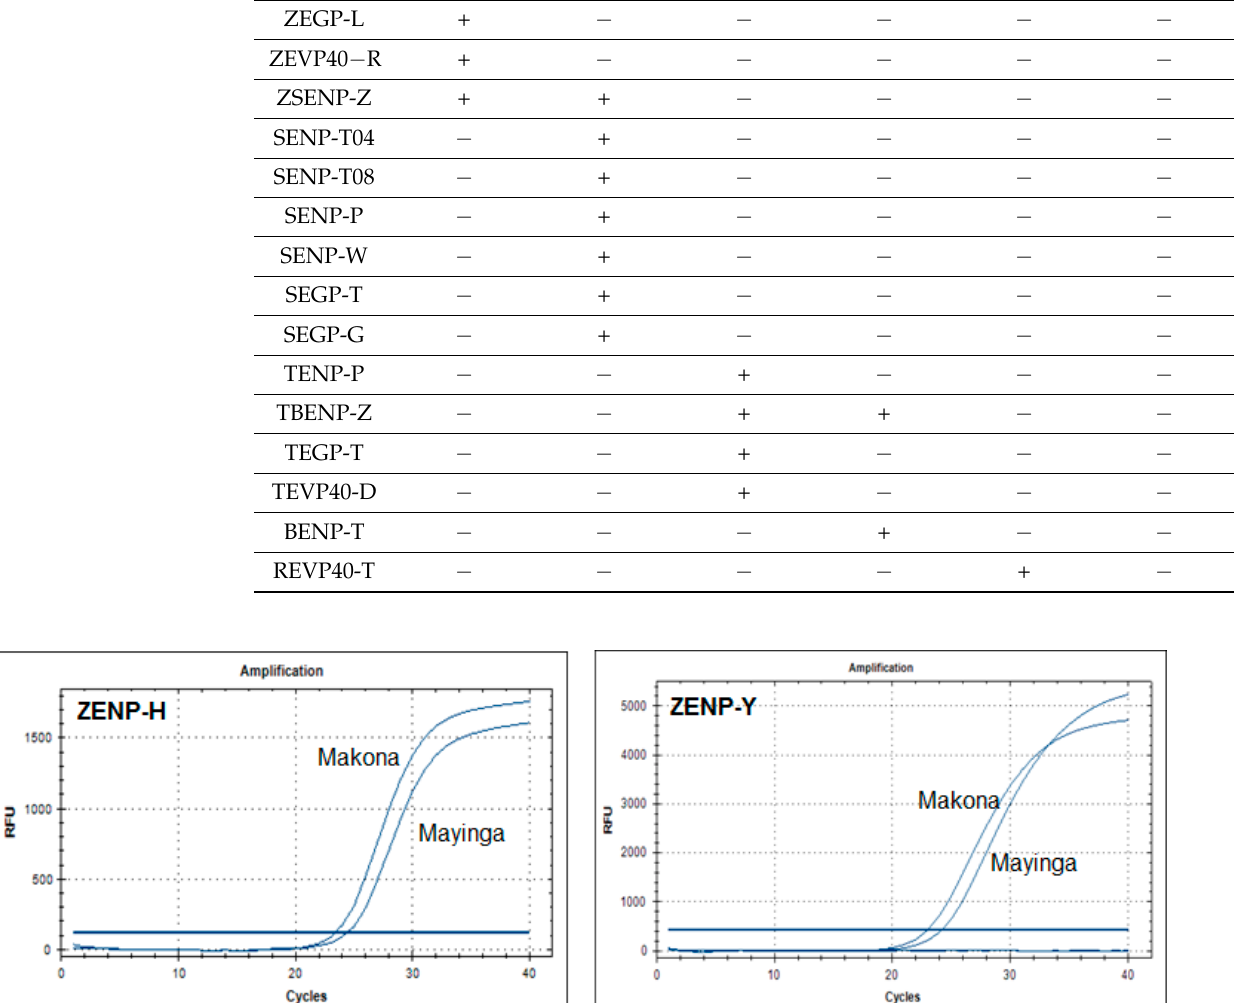
Figure 2. Specificity of ZENP-H, ZENP-Y, ZSENP-Z and ZEVO40-R assays for the EBOV Mayinga variant and the Makona variant. The specificity of ebolavirus species-specific real-time RT-PCR assays was examined using viral RNA extracted from the supernatant of cells infected with the EBOV-Mayinga variant and the Makona variant. Outside these assays, there was no difference in assay specificity between the two variants. 4. Discussion The two deadliest ebolaviruses epidemics have occurred in the past 5 years, and one of these epidemics is still ongoing. In the case of an epidemic emergency, the first line of response should be an accurate and quick virus detection. Nucleic acid detection is the most common procedure for diagnosing EVD because of its unsurpassed specificity and sensitivity, as well as its ability to detect acute infection. Additionally, the virus does not need to be viable at the time of testing [38]. In recent years, real-time RT-PCR for the diagnostics of emerging virus infection has proven to be an invaluable tool for case identification and epidemic control [39–41], e.g., during the ongoing COVID-19 pandemic.